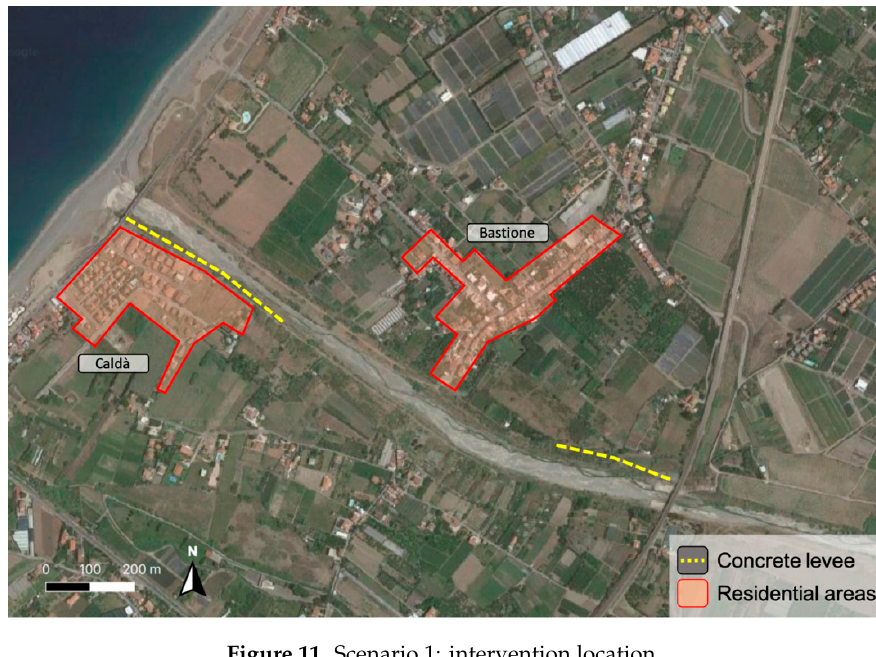
Figure 11. Scenario 1: intervention location.